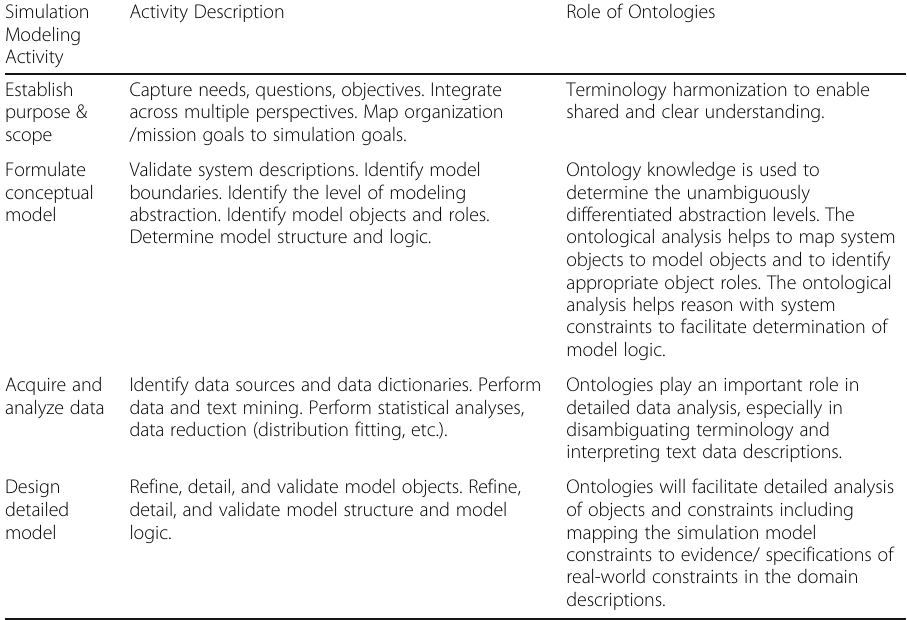
Table 1 How Ontologies Enable the Simulation Model Development Process (Benjamin et